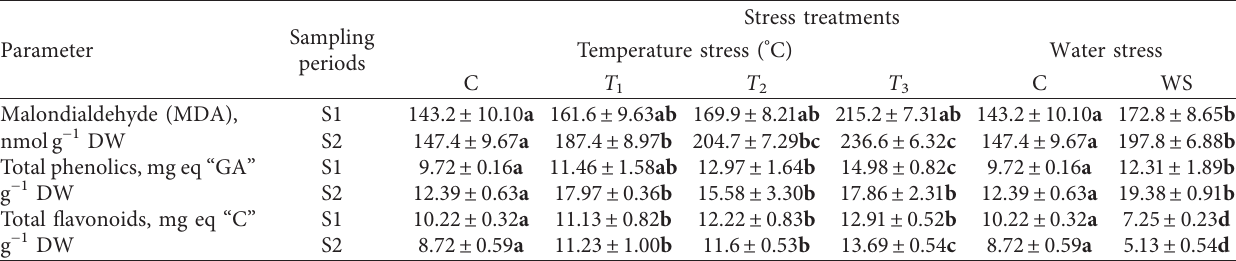
Table 1: Effect of different climate temperatures (C, 25 ° C; T malondialdehyde (MDA), total phenolics, and total flavonoids after two sampling periods (S1, 14 days and S2, 21 days) in basil plants (mean ± SD, n � 10). Different lower case letters indicate significance differences between treatments for the same sampling period according to the Tukey test ( α �